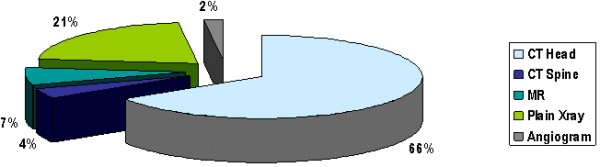
A diagrammatic representation of the break-up of the examinations performed between 15/1/04 to 15/4/04 (n = 507).